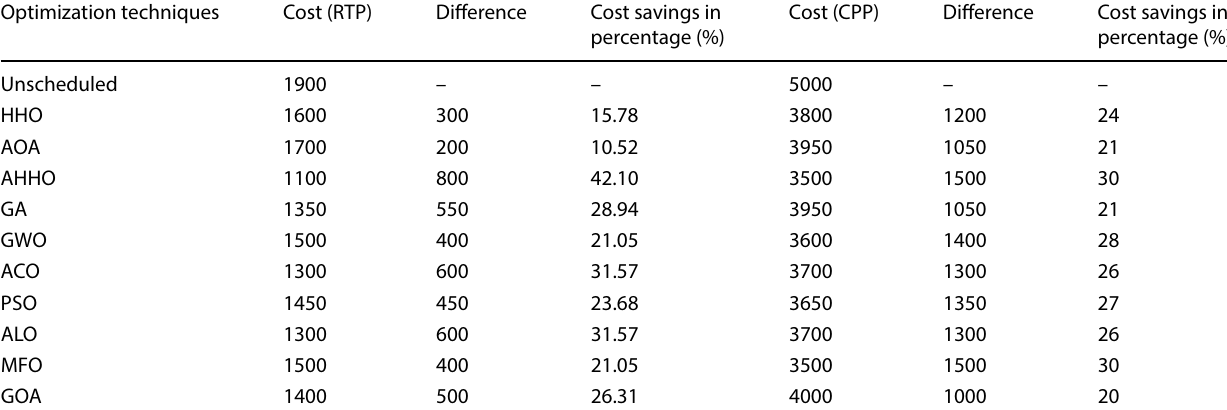
Table 2 Cost comparison with the unscheduled scheme Optimization techniques